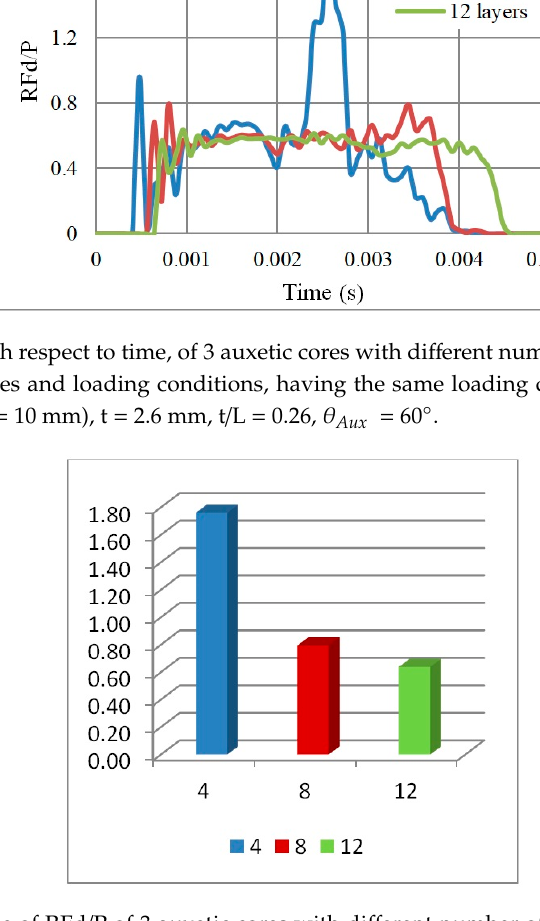
Figure 21. Peak value of RFd/P of 3 auxetic cores with different number of layers; having the same geometrical properties and loading conditions.